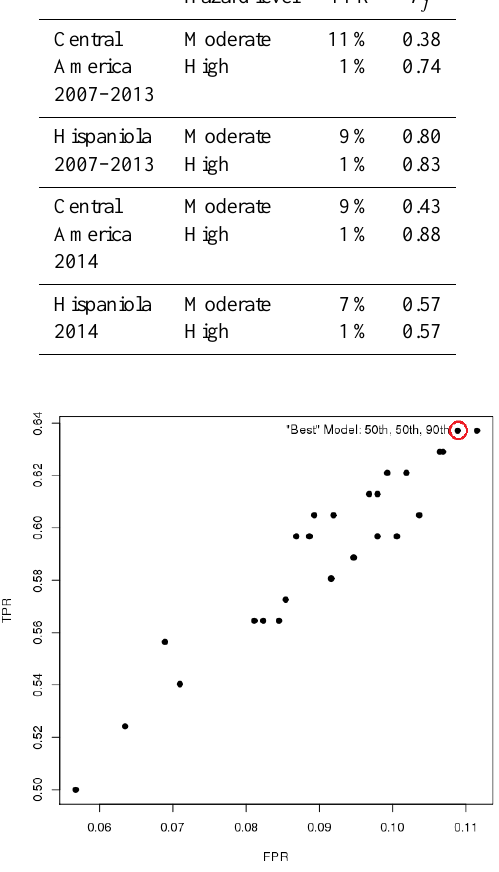
Table 2. True positive rate (TPR) considered over 0, 1, 5km buffers and a variable buffer based on the reported location accuracy. Tem- poral windows of 1, 3 and 7 days were also evaluated. Results are shown in percentages, with high-hazard TPR percentages shown in parentheses. The susceptible pixels column (far right) shows the percentage of reported landslides that have a susceptibility index of 2 or greater within the spatial buffer considered, indicating the maximum TPR that could be generated based on the rainfall and antecedent thresholds of the model.